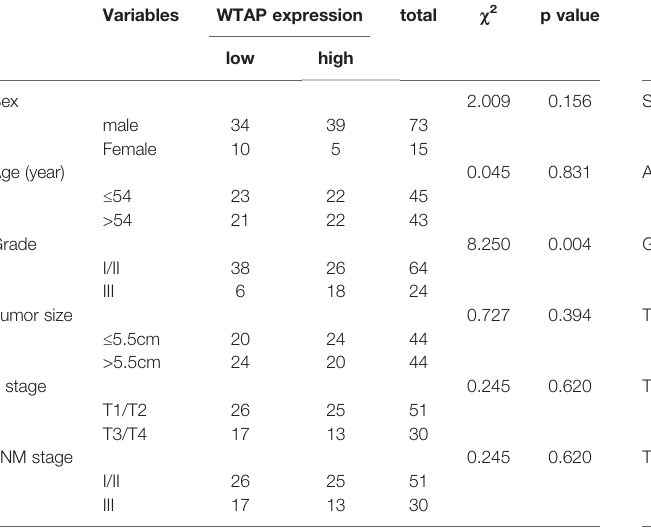
TABLE 1 | Relationship between WTAP expression levels in the cytoplasm and clinicopathological characteristics in HCC patients. Variables WTAP